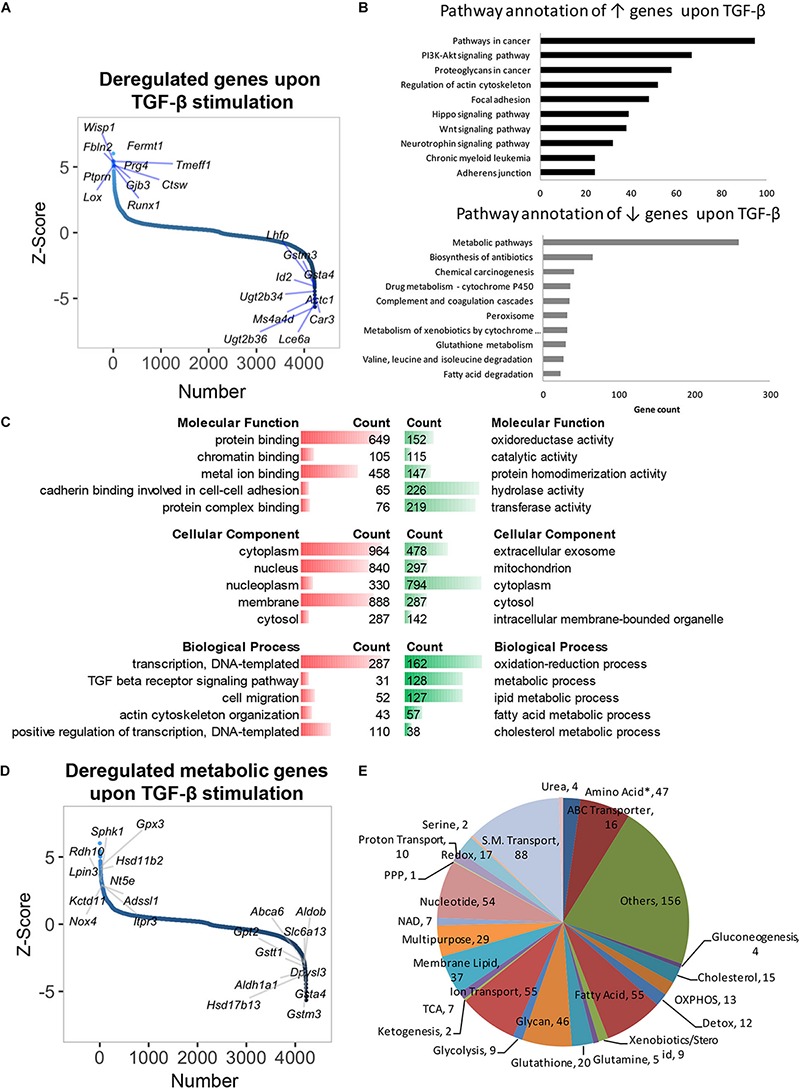
Gene expression profile and deregulated metabolic genes of primary hepatocytes treated with TGF-β for 48 h. (A) Distribution of altered genes by Z-score (N = 4224, highlighted top 10 up- and top 10 downregulated genes). (B) KEGG pathway annotation of total upregulated or downregulated genes indicated that TGF-β stimulation suppressed metabolic genes. (C) Molecular functions, biological processes, and cellular component analyses of total deregulated genes. (D) Distribution of deregulated genes by Z-score (N = 4224, highlighted metabolic top 10 upregulated and top 10 downregulated genes). (E) Classification of 721 deregulated metabolic genes in biochemical metabolic processes. ↑, upregulated; ↓, downregulated; red, upregulated; green, downregulated. ∗, all amino acids besides glutamine and serine.